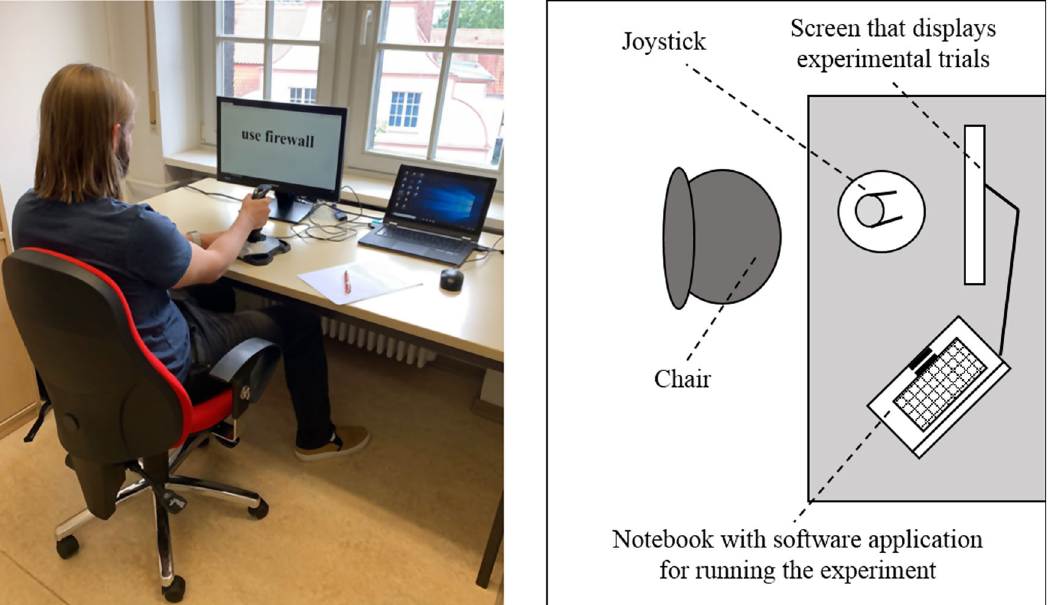
Fig. 10 A depiction of the Push/Pull study. On the left, a photograph of one of the researchers sitting in front of the test computer. On the right is a graphical depiction of the push/pull study